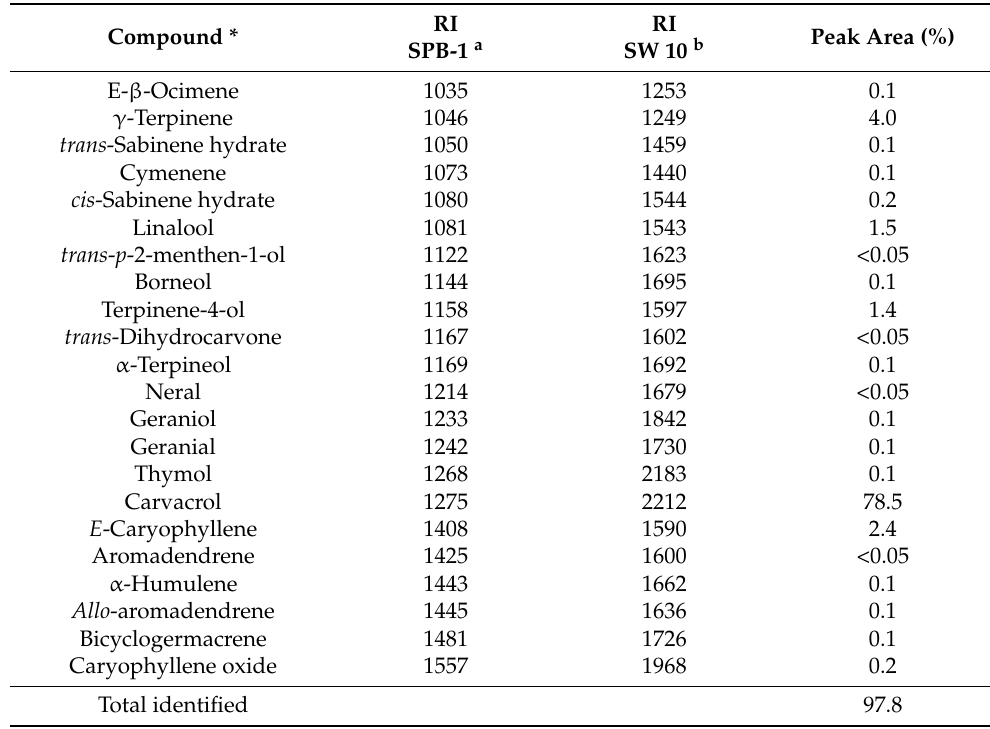
RI SW 10: GC retention indices on the Supelcowax-10 column. GC-FID chromatogram of EO on the SPB-1 column is shown in Figure 1. Carvacrol, the predominant compound of the oil, is marked on the chromatogram.